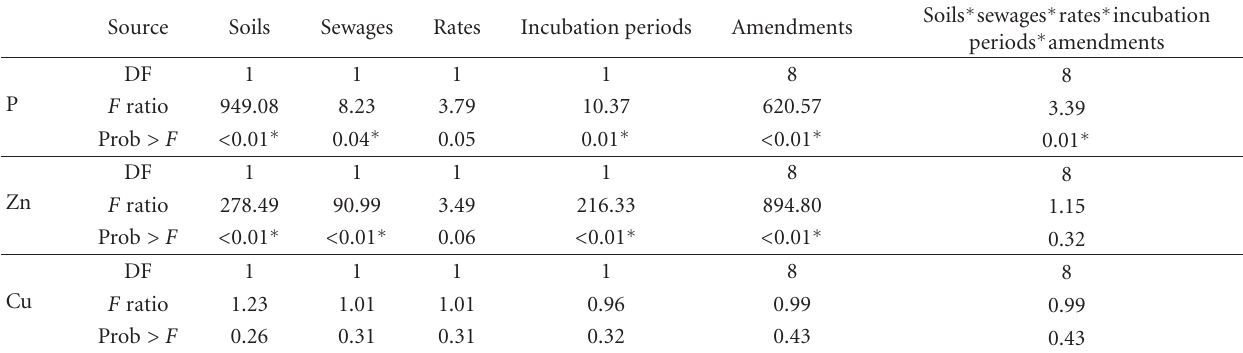
Table 5: Multifactor analysis of statistical di ff erences in P, Cu, and Zn concentrations as a ff ected by soil types, sewage source, mixing rate, and incubation